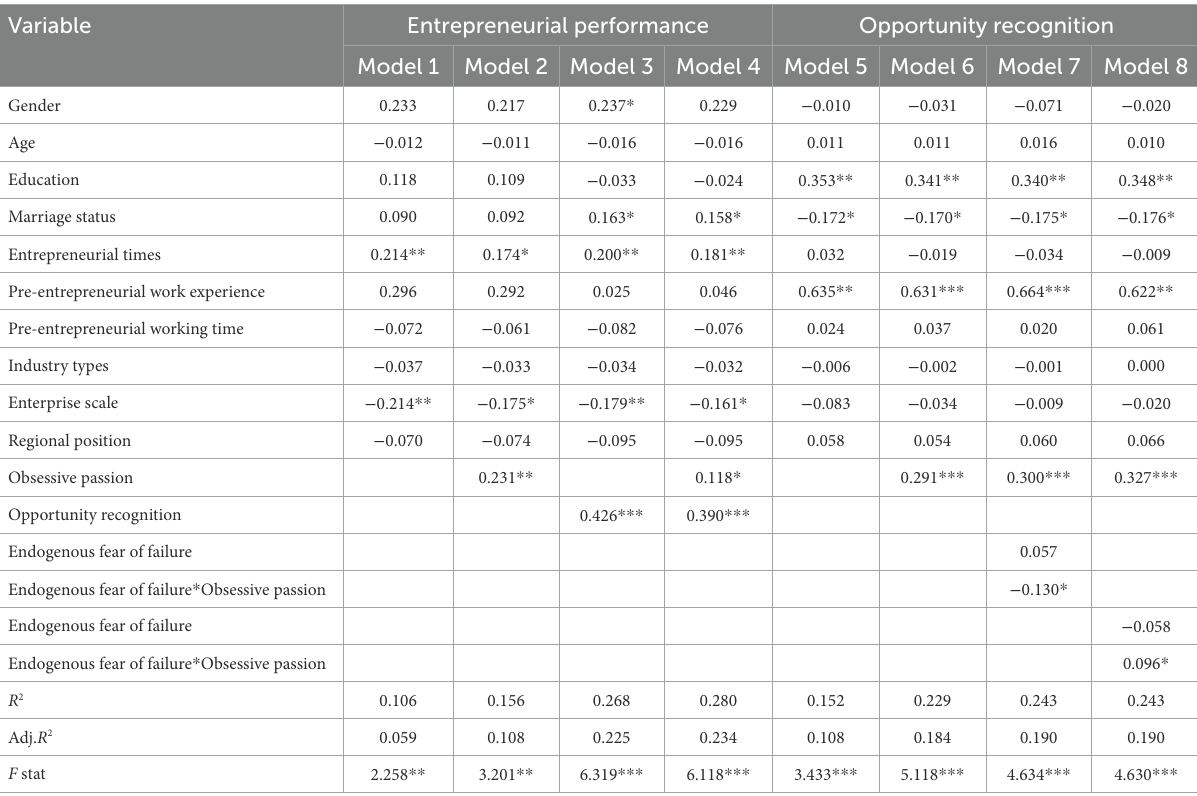
TABLE 5 Robustness